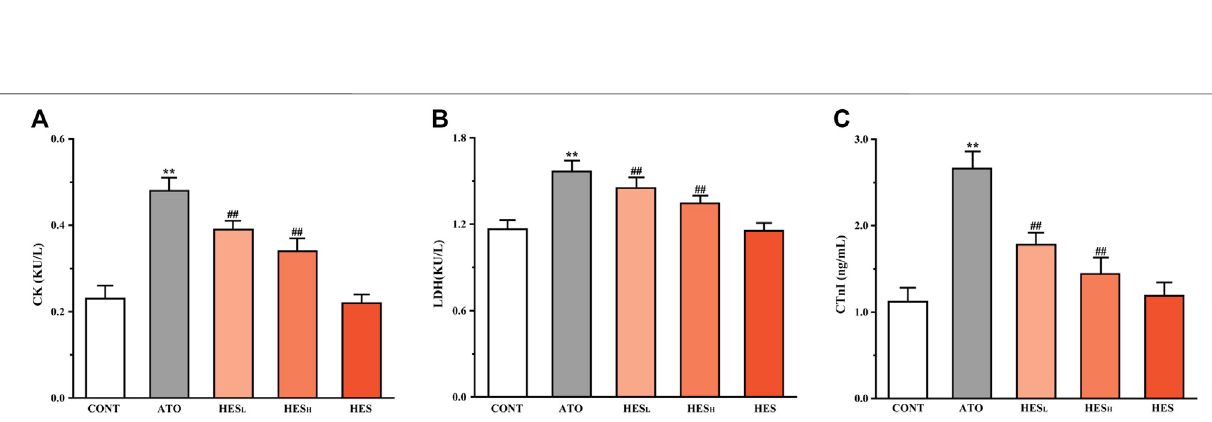
Frontiers in Pharmacology |